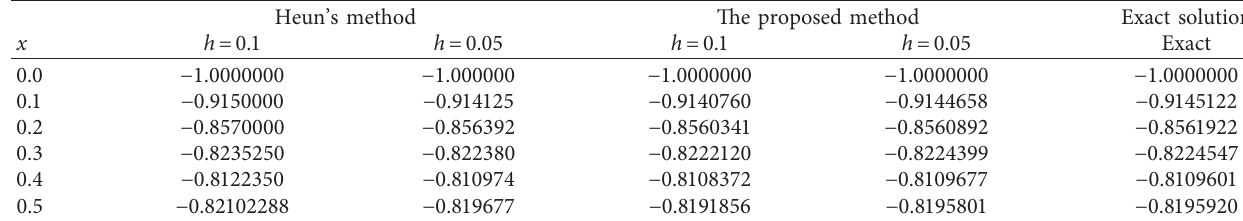
Table 3: Numerical solutions and exact solution for Example 2.